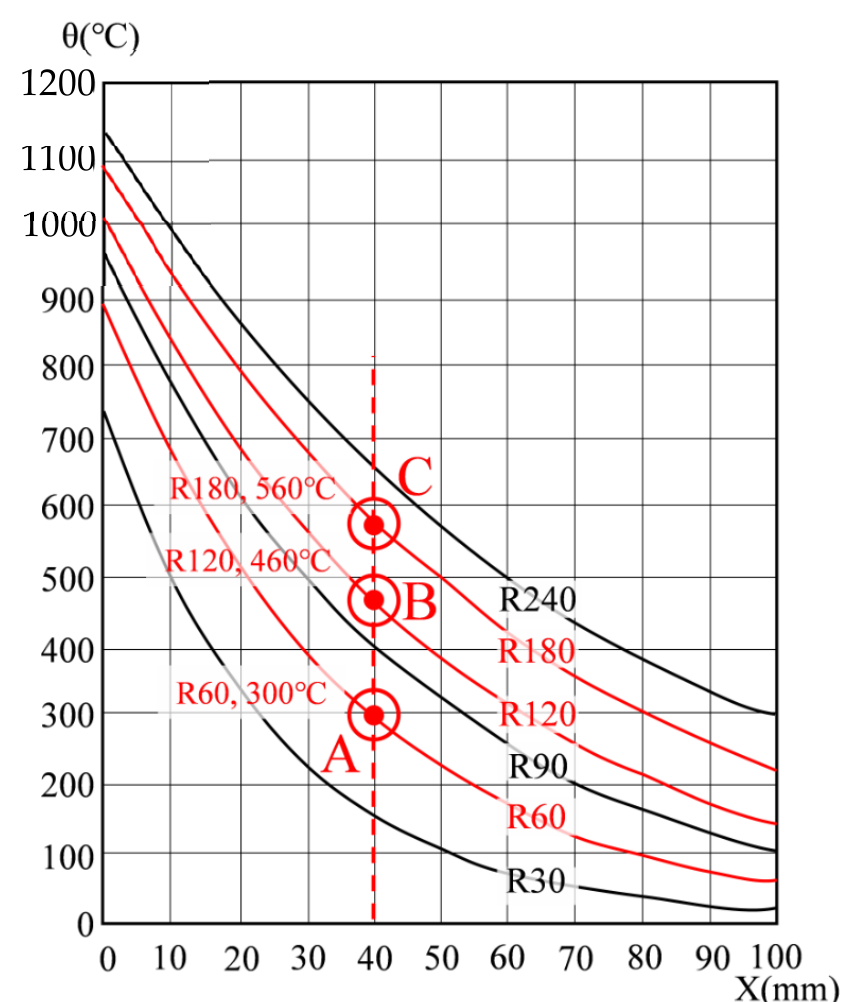
Figure 10. Temperature profiles for slabs (X = 40 mm) (EN 1992-1-2, reproduced).